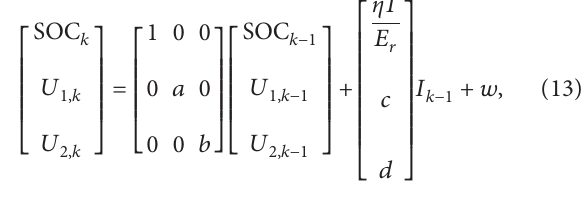
Figure 2: OCV-SOC relationship